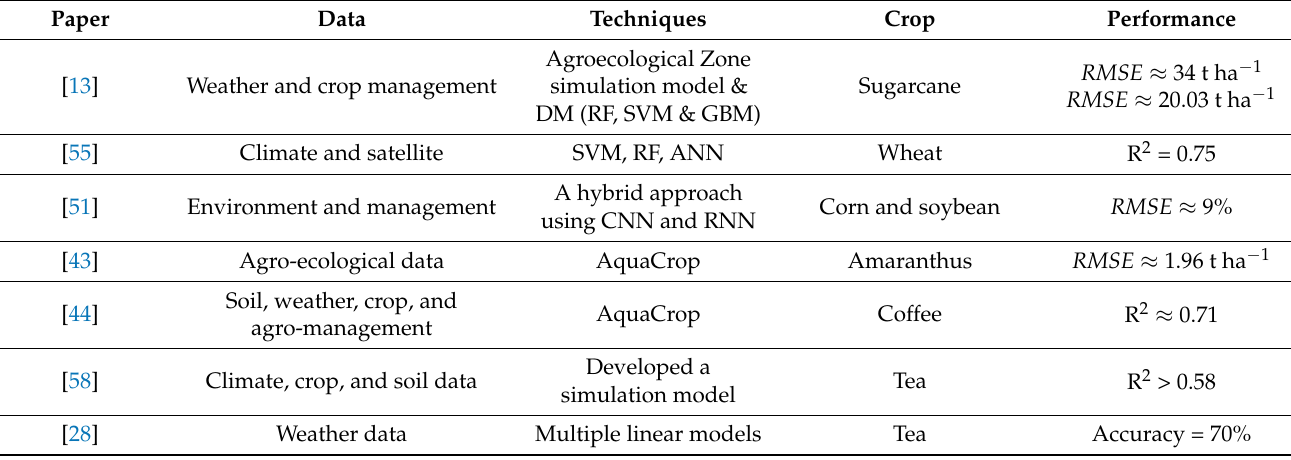
Table 1. Summary of related work for different crops.